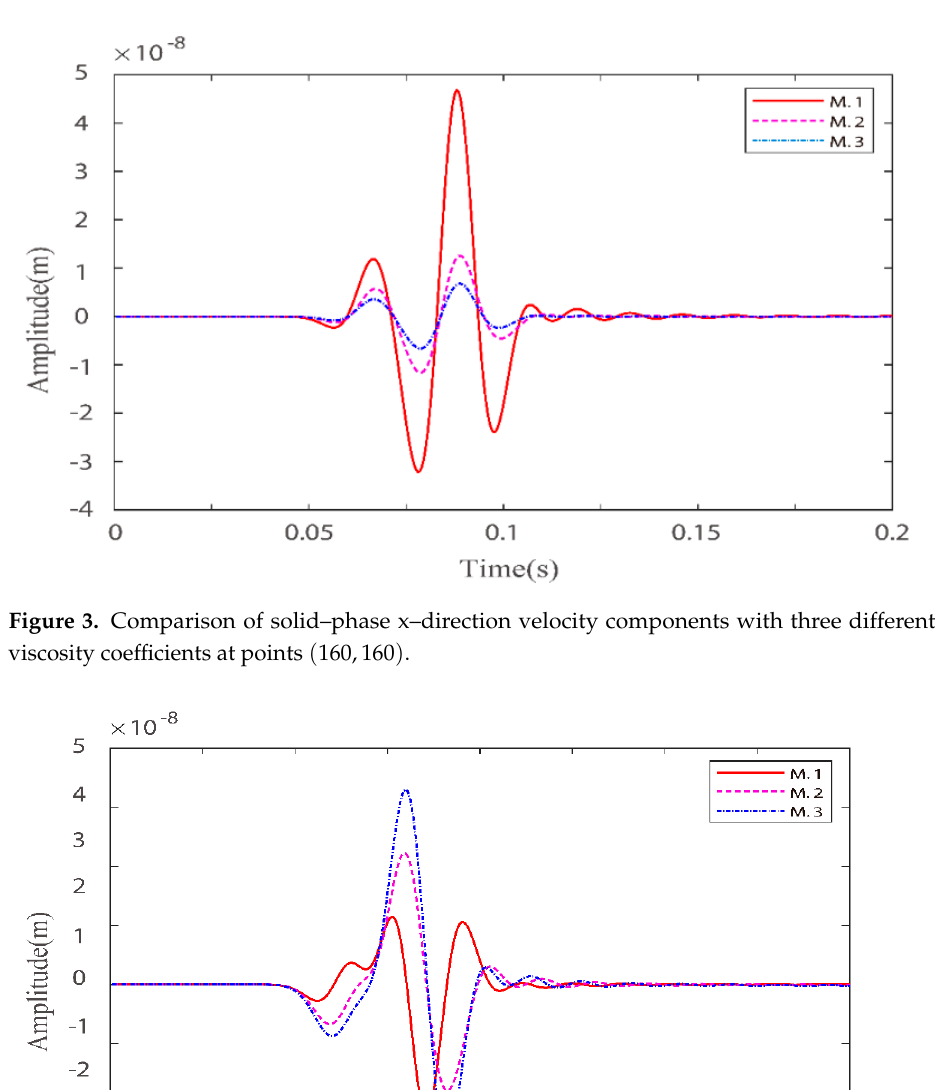
cosity coefficients at t (cid:3404) 0.15s .